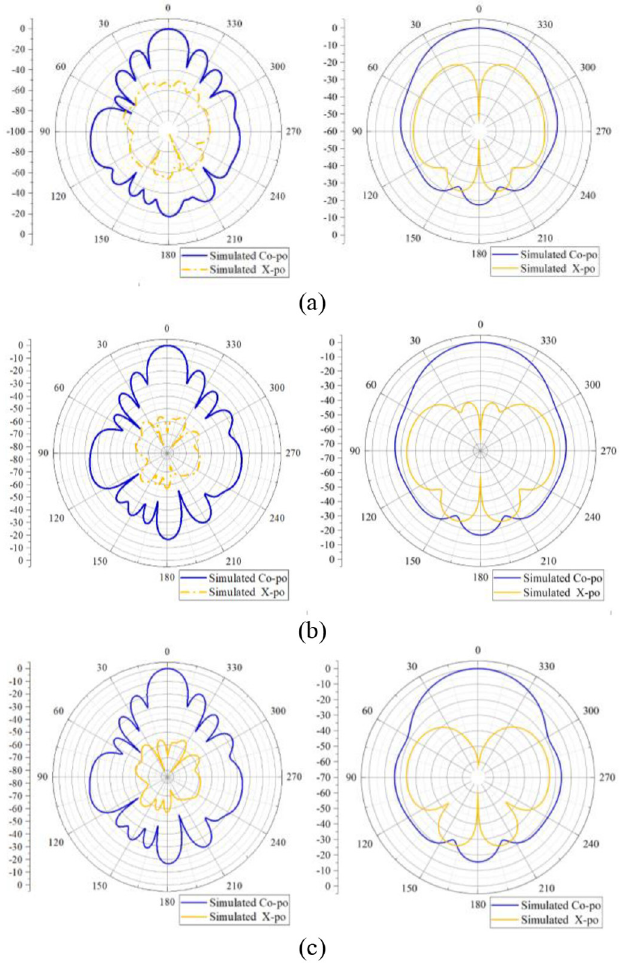
Fig. 8. Simulated co- and cross-polarized radiation patterns in zoy -plane and zox -plane, (a) 3.4 GHz, (b) 3.5 GHz, (c) 3.6GHz.